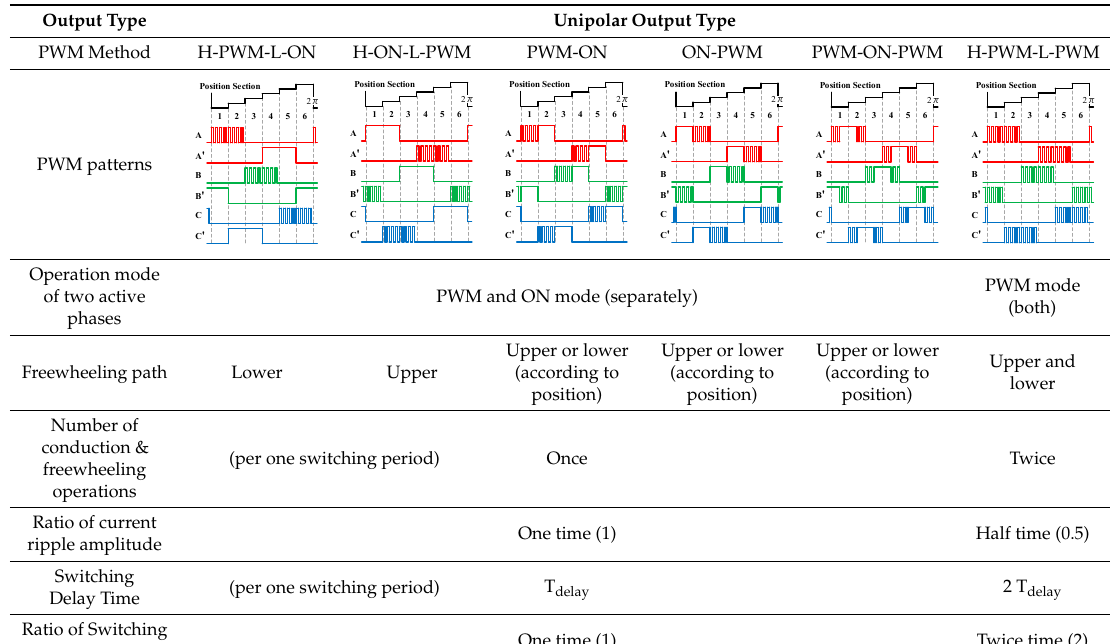
Table 1. Operating and electrical characteristics of unipolar PWM methods for BLDC motors.